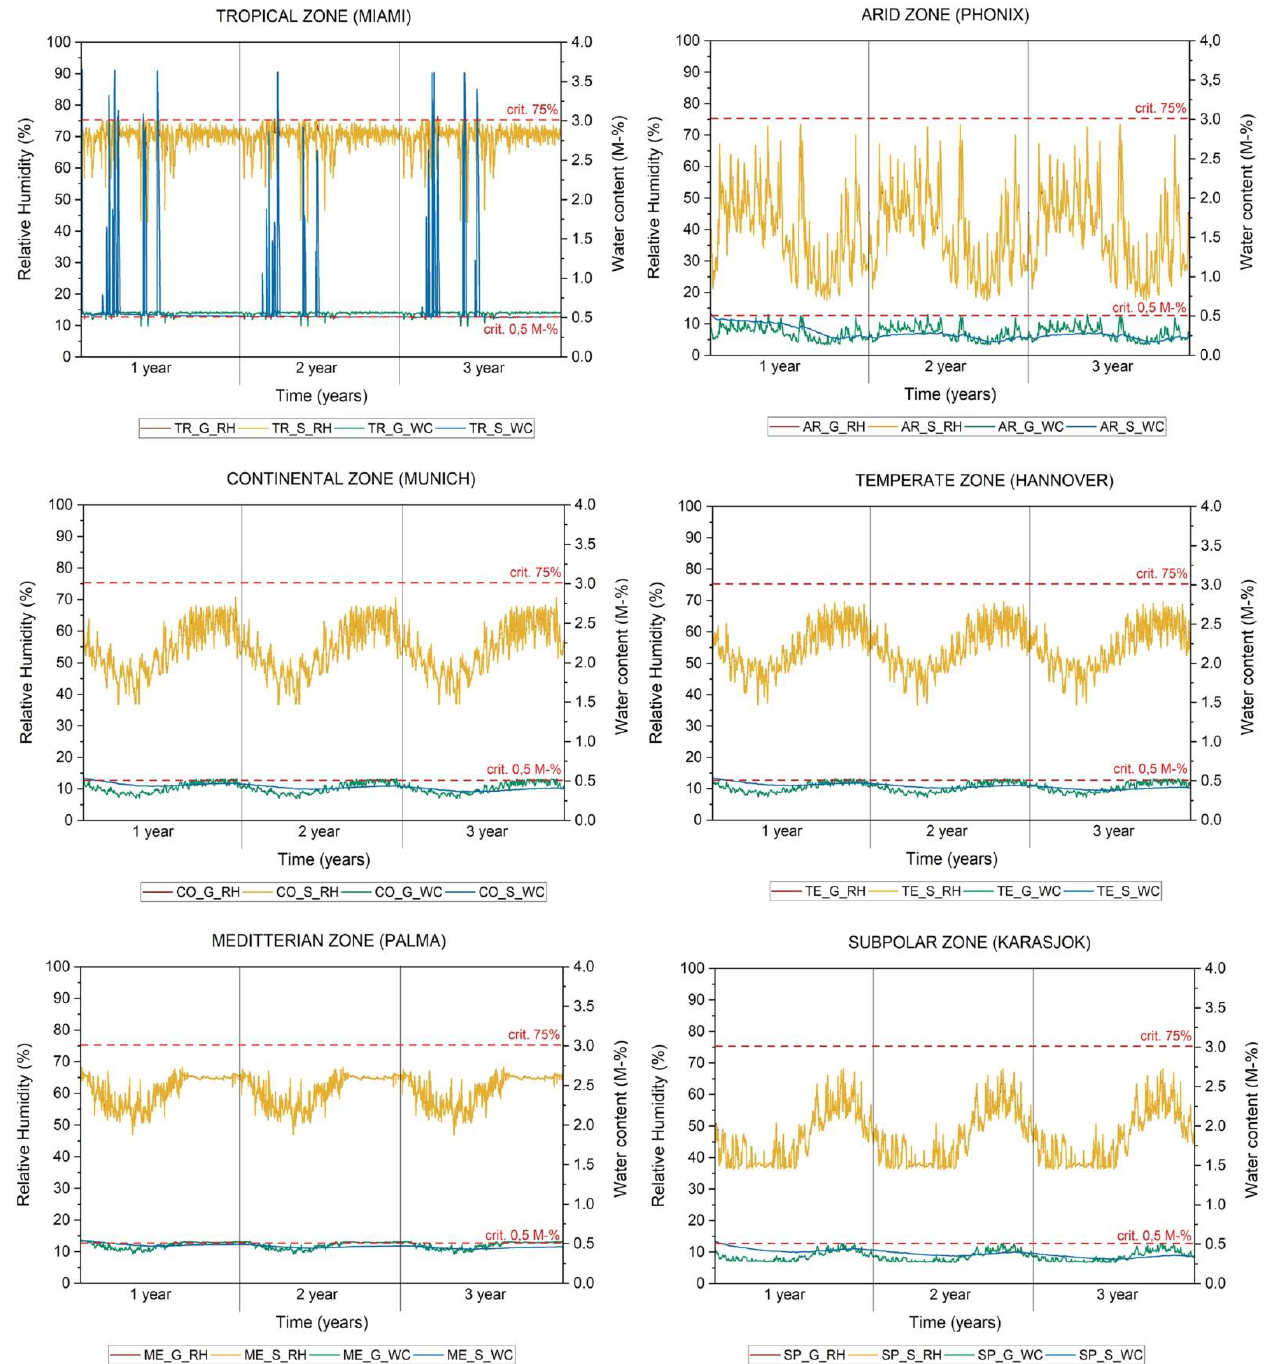
Figure 5. Simulated RH and water content of salt and gypsum over three years (G_RH—gypsum and relative humidity, S_RH—salt and relative humidity, G_WC—gypsum and water content, S_WC—salt and water content).